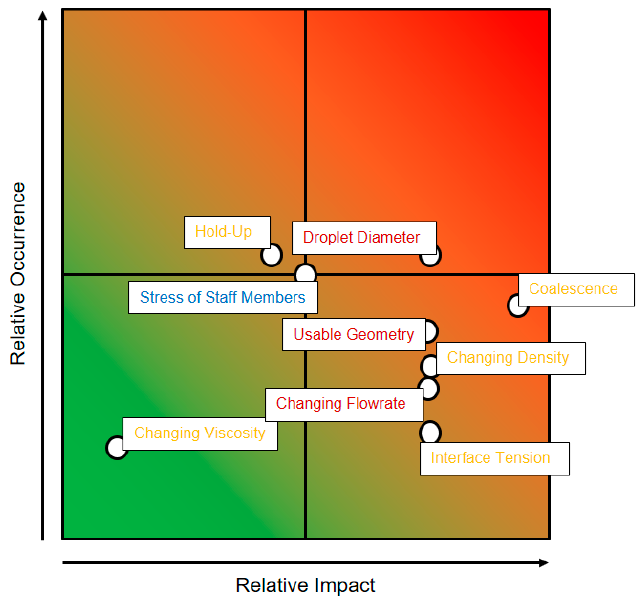
Figure 22. Representation of the effects and relative probability of the studied disturbances of the process.